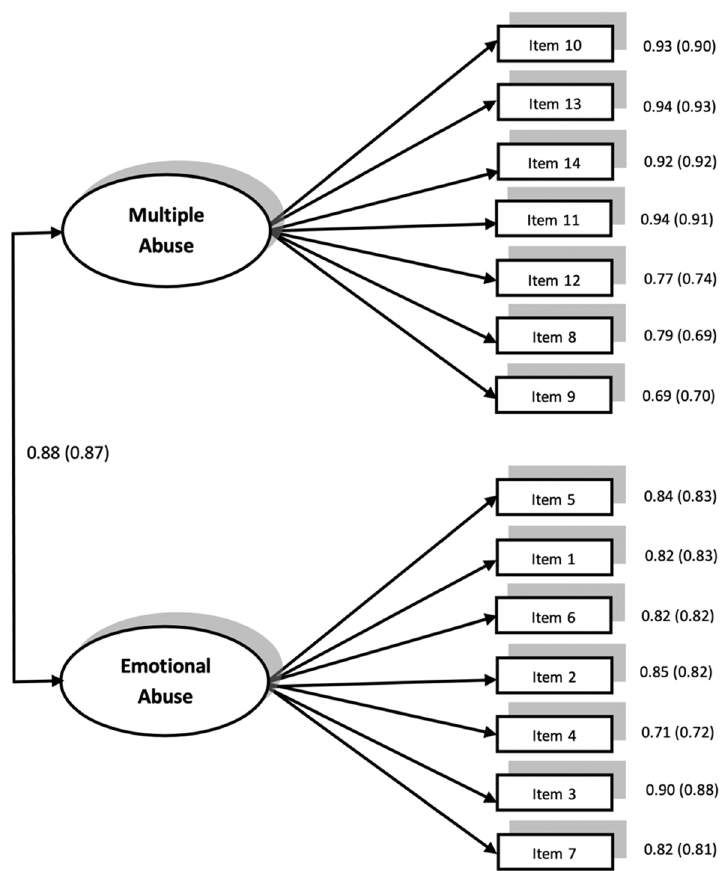
Figure 1. Confirmatory Factor Analysis of the Questionnaire of Perception of Inter-Partner Violence from boy-to-girl and girl-to-boy (in brackets). Factor loadings are standardized. Reliability. In Tables 1 and 2, we see the correlations of each item with the total number of the factor to which they belong (multiple or emotional abuse) (biserial-punctual correlation). There are no items with correlations lower than 0.20; therefore, it would not be advisable to eliminate any of them [2]. The internal consistency (Cronbach’s Alpha) of the obtained factors was very high: (1) perception of boy-to-girl violence was 0.942 for multiple and 0.930 for emotional abuse; (2) perception of girl-to-boy violence was 0.930 for multiple and 0.926 for emotional